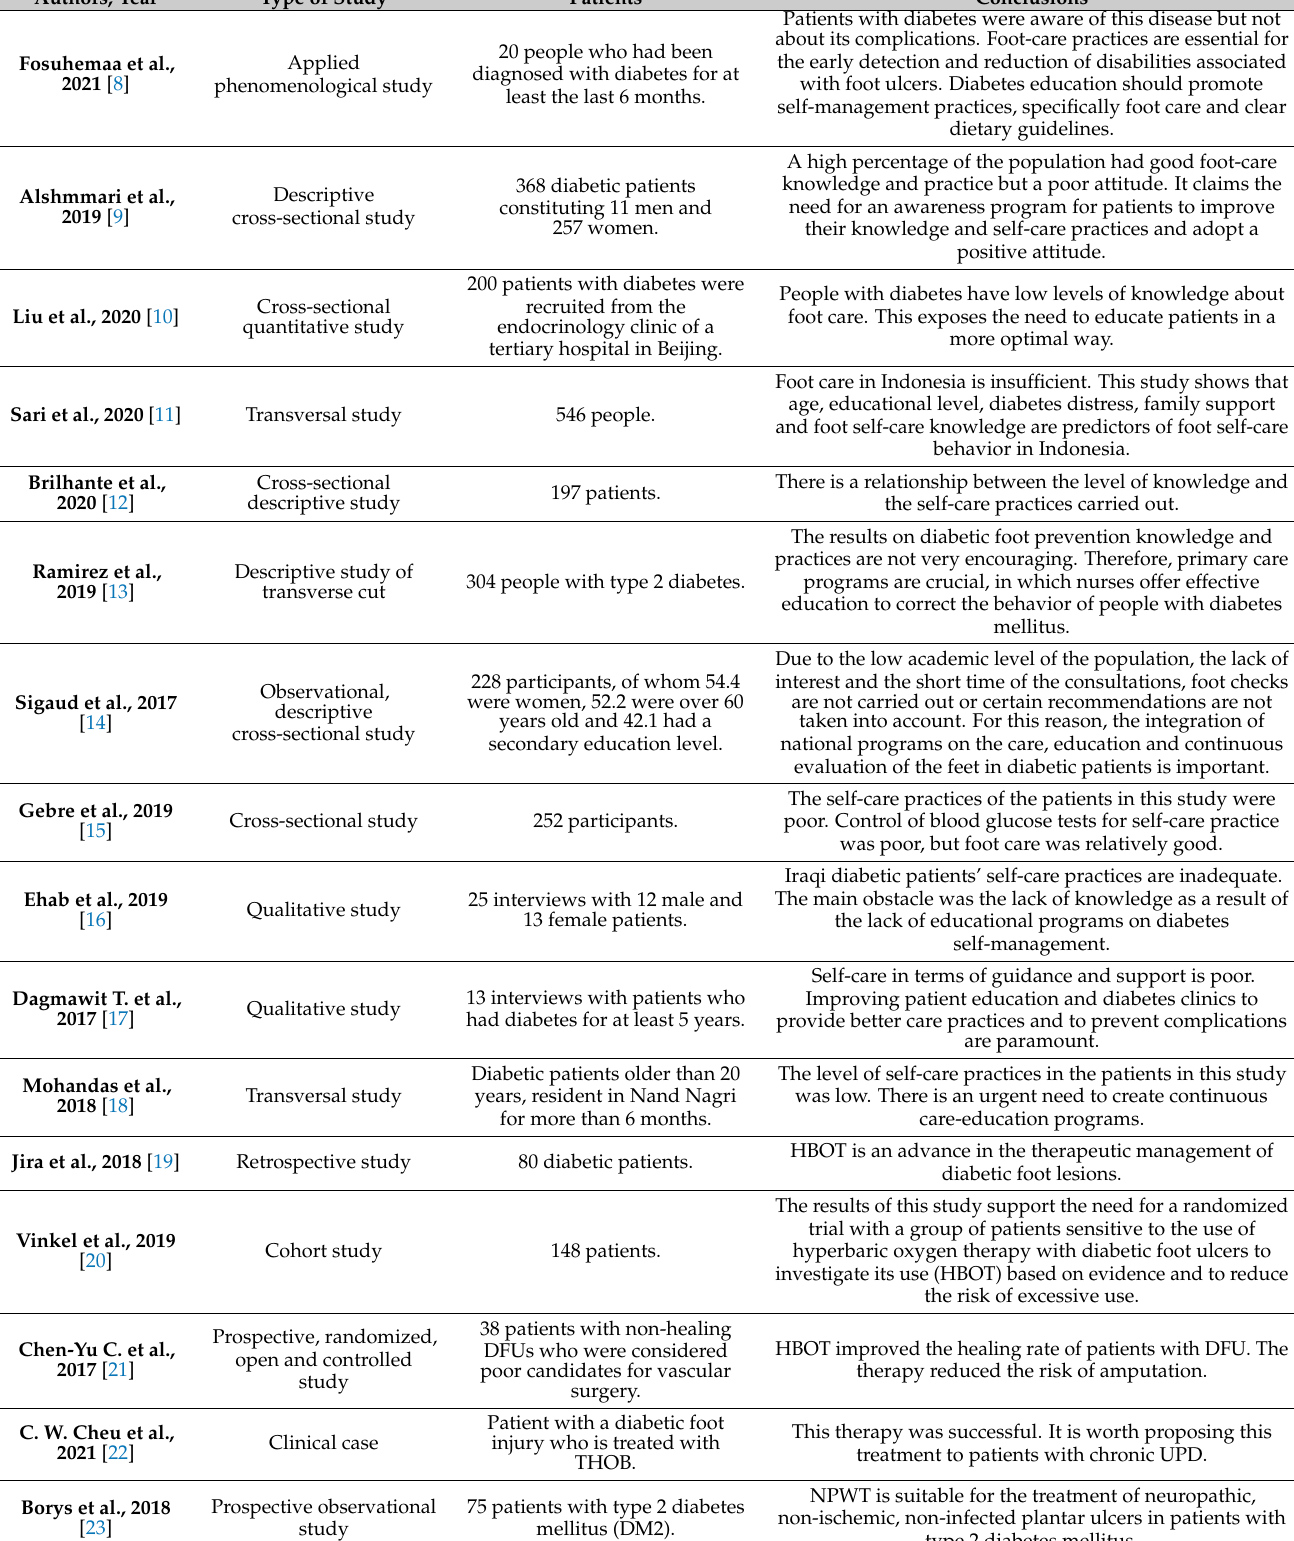
Table A3. Selected Scientific Articles